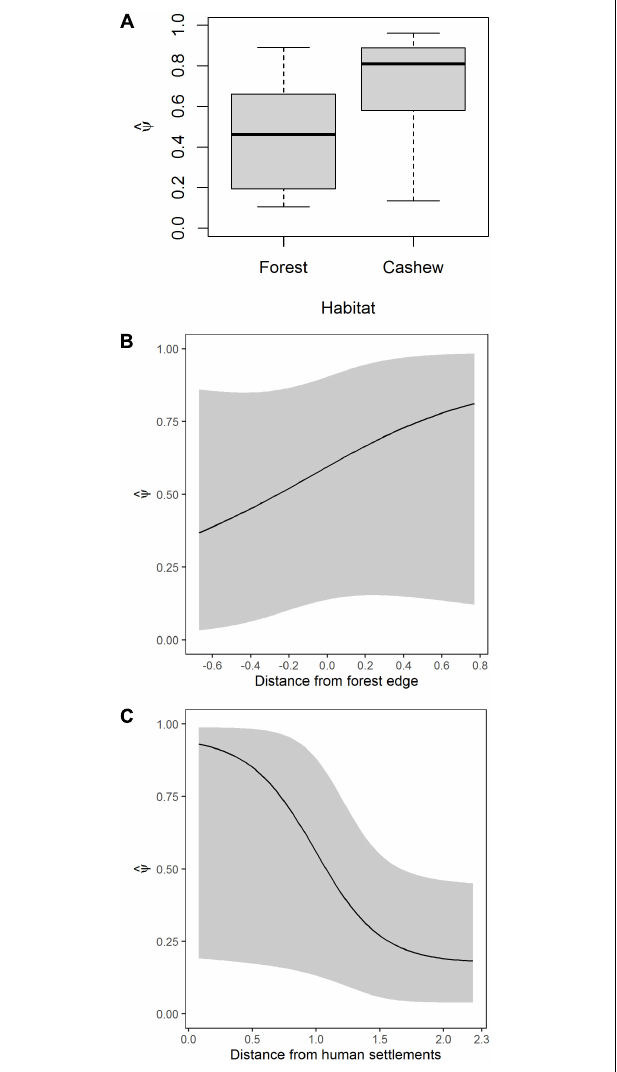
FIGURE 4 | Model-averaged estimates of habitat use of wild pig as a function of (A) habitat type (B) , distance from nearest forest edge, and (C) distance to nearest human